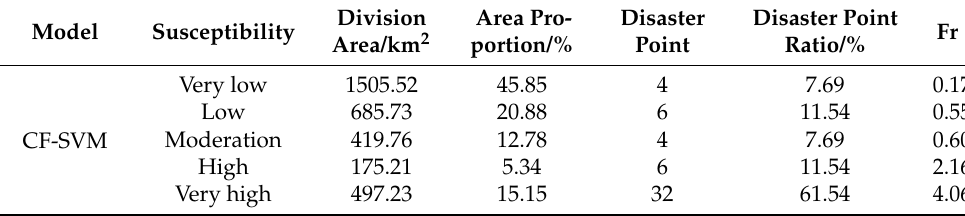
Table 4. Statistical table of prone